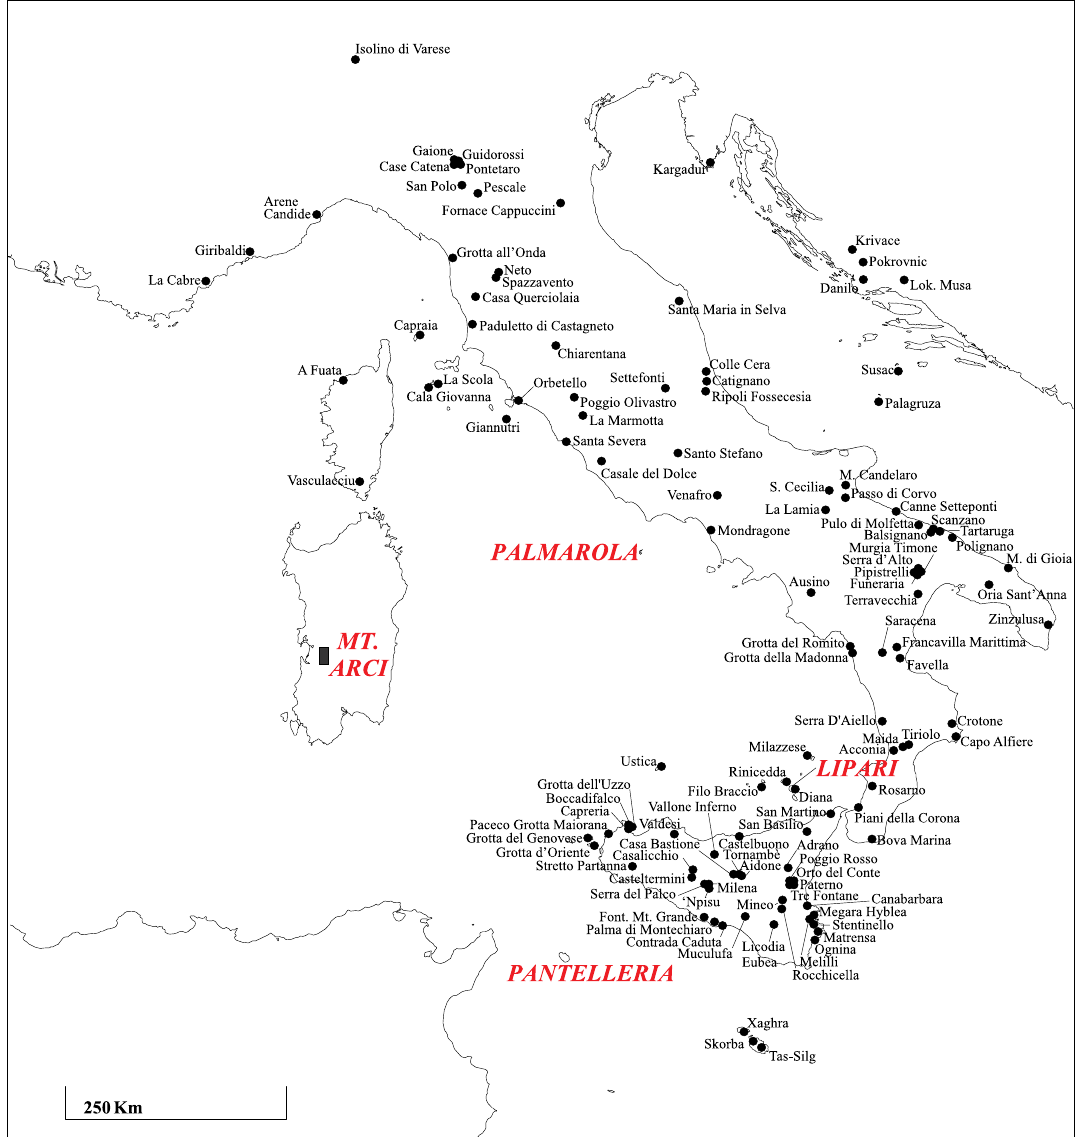
Figure 15. Sites with Lipari obsidian and ≥ 10 artifacts